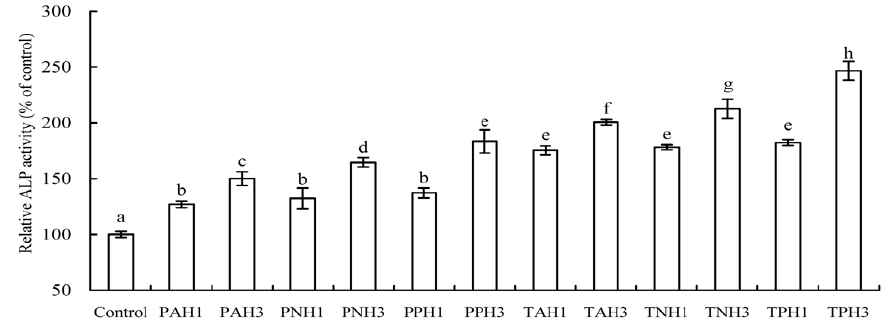
Figure 4. Alkaline phosphatase (ALP) activity of the osteoblasts exposed to 12 gelatin hydrolysates for 7 days. Different letters above the columns indicate that one-way ANOVA of the means differs significantly ( p < 0.05).